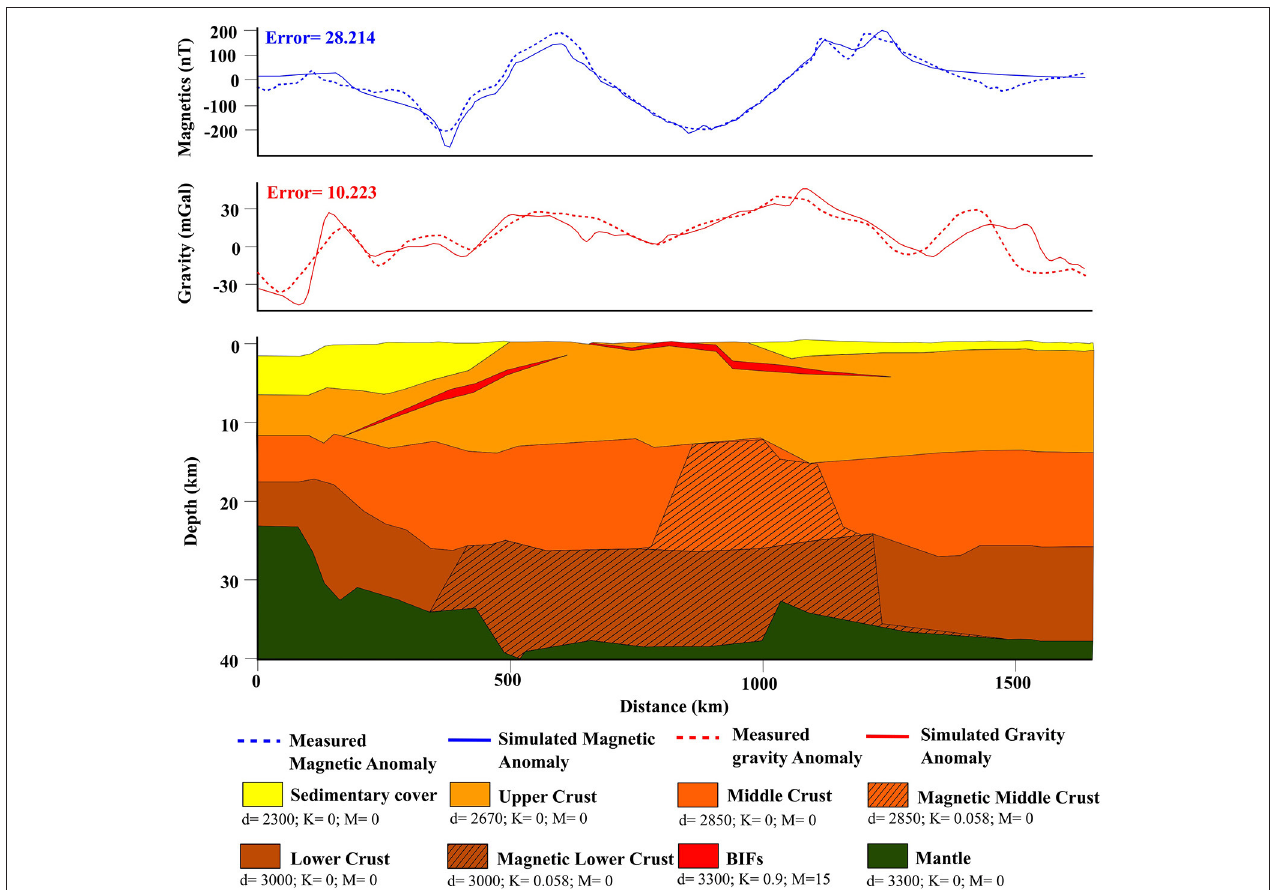
FIGURE 10 | Model of the crustal structure along profile C beneath the WAMA with remanence, considering mid-crustal thick BIF layers. The parameters are identical to the ones in Figure 8 .